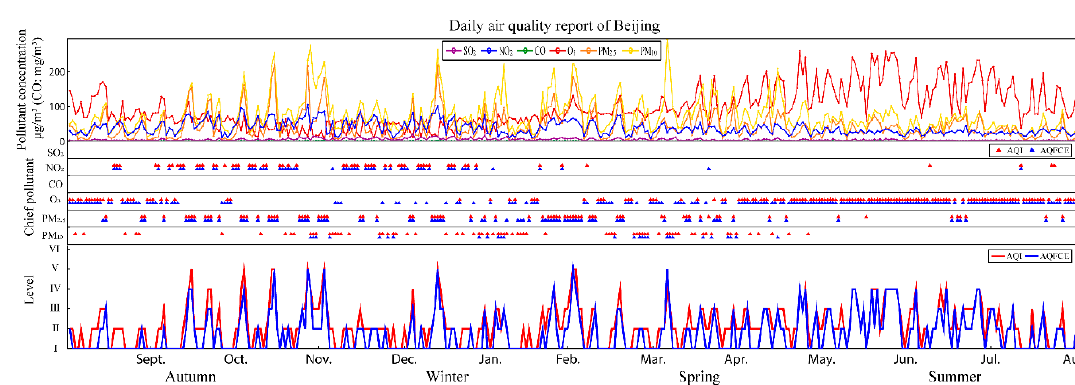
Figure 3. Daily pollutant concentration variation and air quality evaluation result of chief pollutant and level of Beijing.